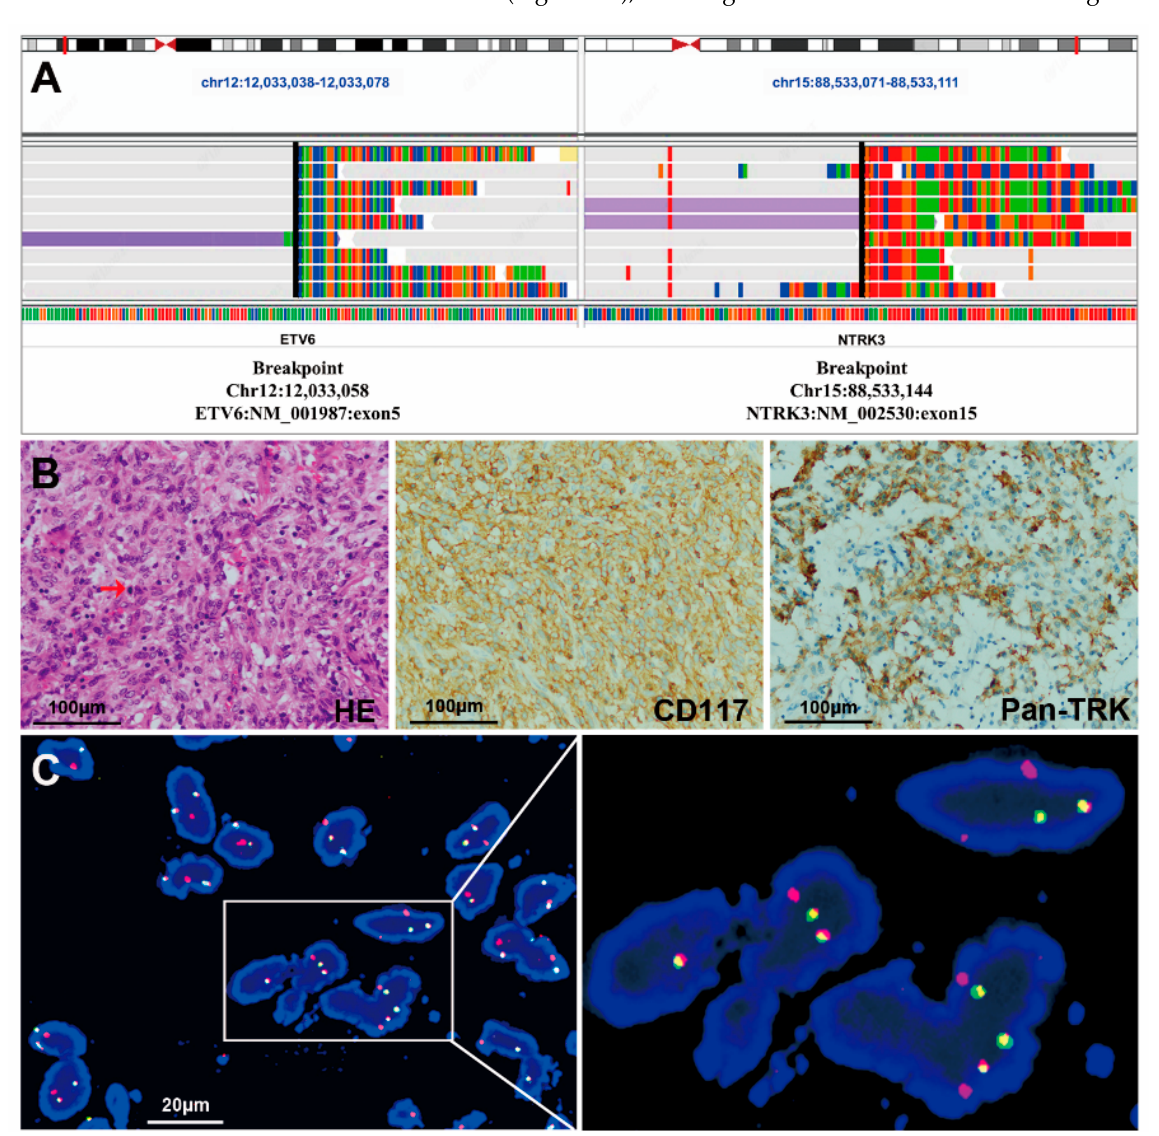
Figure 2. IGV, HE staining, immunohistochemical staining and FISH images of a mesenteric GIST with an ETV6-NTRK3 fusion (case #1). ( A ) IGV images of NGS showed the ETV6-NTRK3 fusion. ( B ) The tumor was composed of spindle-shaped or short spindle-shaped cells, and mitosis was observed (red arrow) (HE staining, 400×). Immunohistochemical staining showed strong positive expression of CD117 (400×) and Pan-TRK (400×). Each scale bar is 100µm. ( C ) The FISH assay showed a pair of fused red and green signals using ETV6-NTRK3 fusion probes in almost all tumor cells. Scale bar is 20µm.